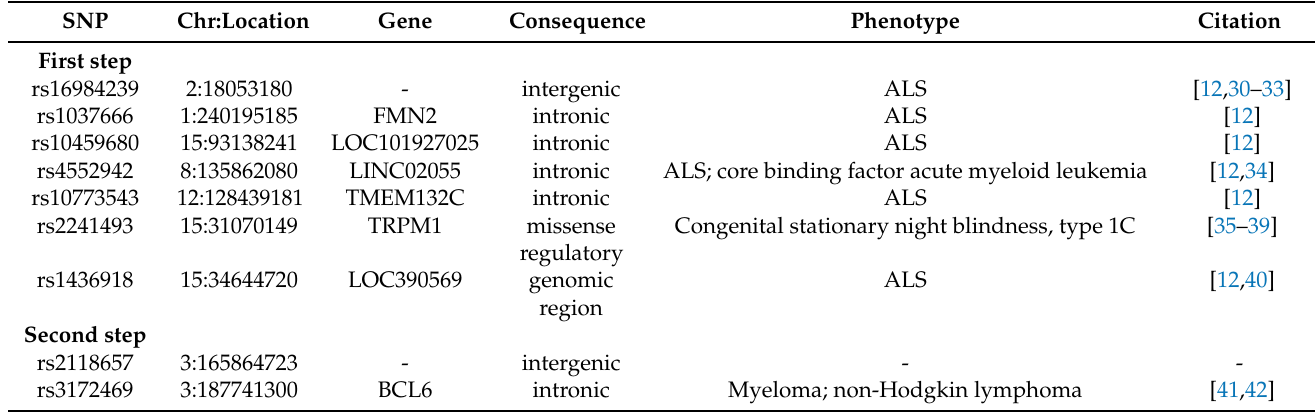
Table 2. Genome position and genomic context of the selected single-nucleotide